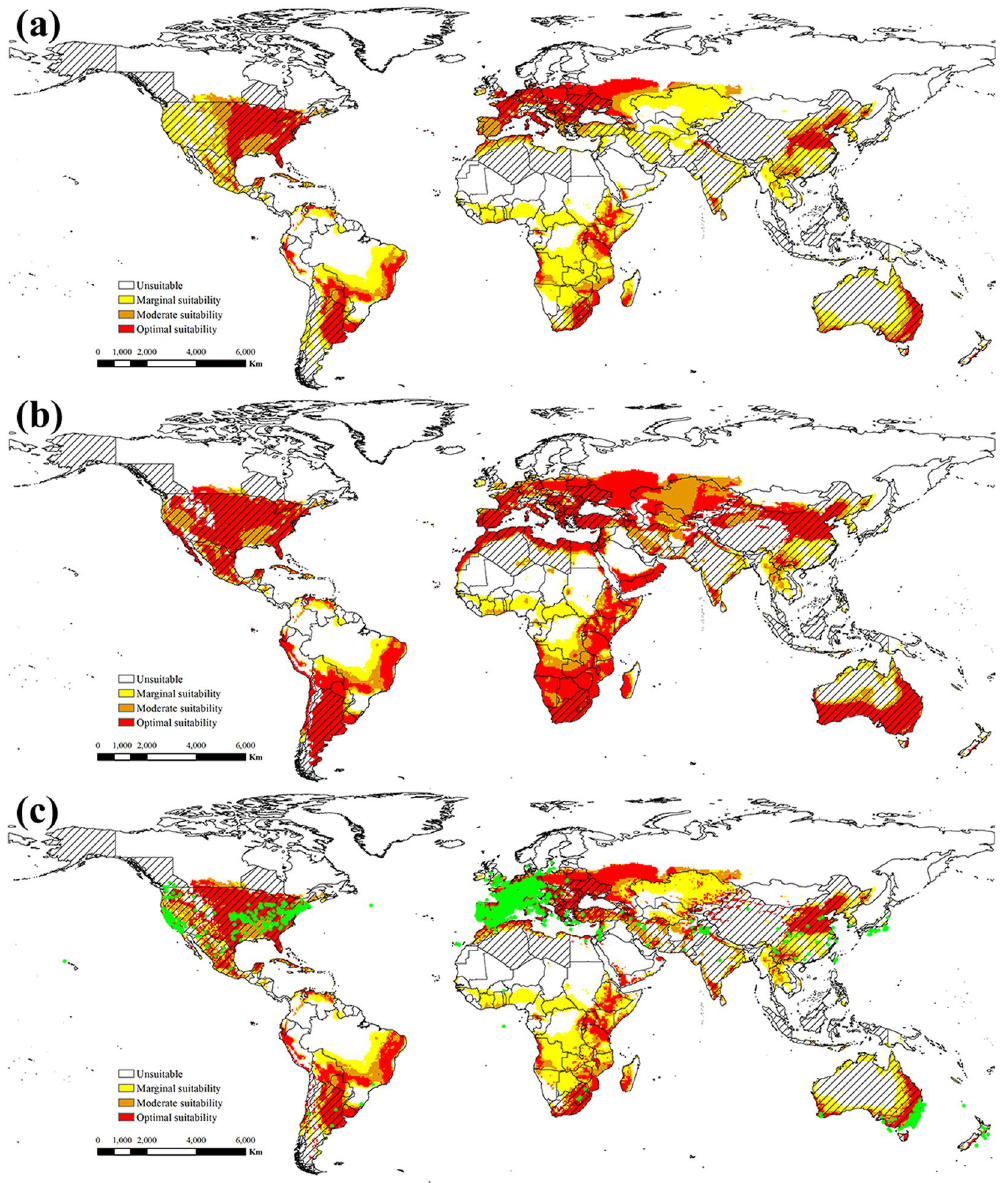
Figure 2. The projected global climate suitability for EBR under the historical climate, ( a ) without irrigation, ( b ) with 2.5 mm in the summer and 1.5 mm in the winter top-up irrigation and ( c ) with a composite risk irrigation scenario (where areas are not under irrigation, the EI of the natural rainfall scenario is mapped, while with areas under irrigation the EI of the irrigation scenario is mapped), using the CLIMEX EI. Slash indicate the distribution countries of tree-of-heaven. Green points indicate the distribution locations of tree-of-heaven. Yellow indicates areas of marginal suitability (0 < EI ≤ 10); Orange indicates areas of moderate suitability (10 < EI ≤ 20); Red indicates areas of optimal suitability (EI ≥ 20). The map in this figure was generated by ArcGIS 10.1 (ESRI, Redlands, CA, USA,